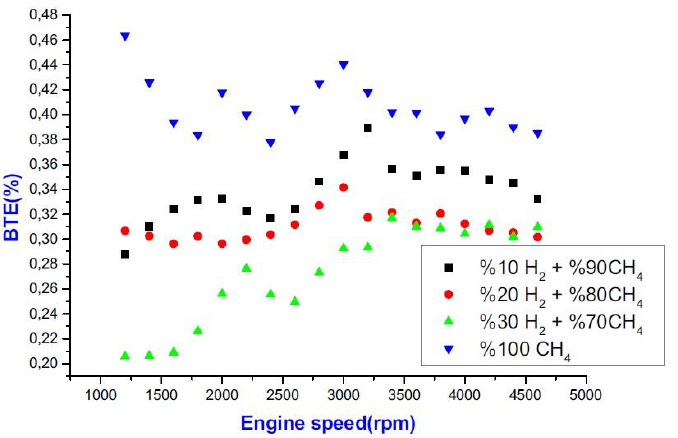
Figure 10. Brake thermal efficiency with different percentages of hydrogen in the SI engine [75].